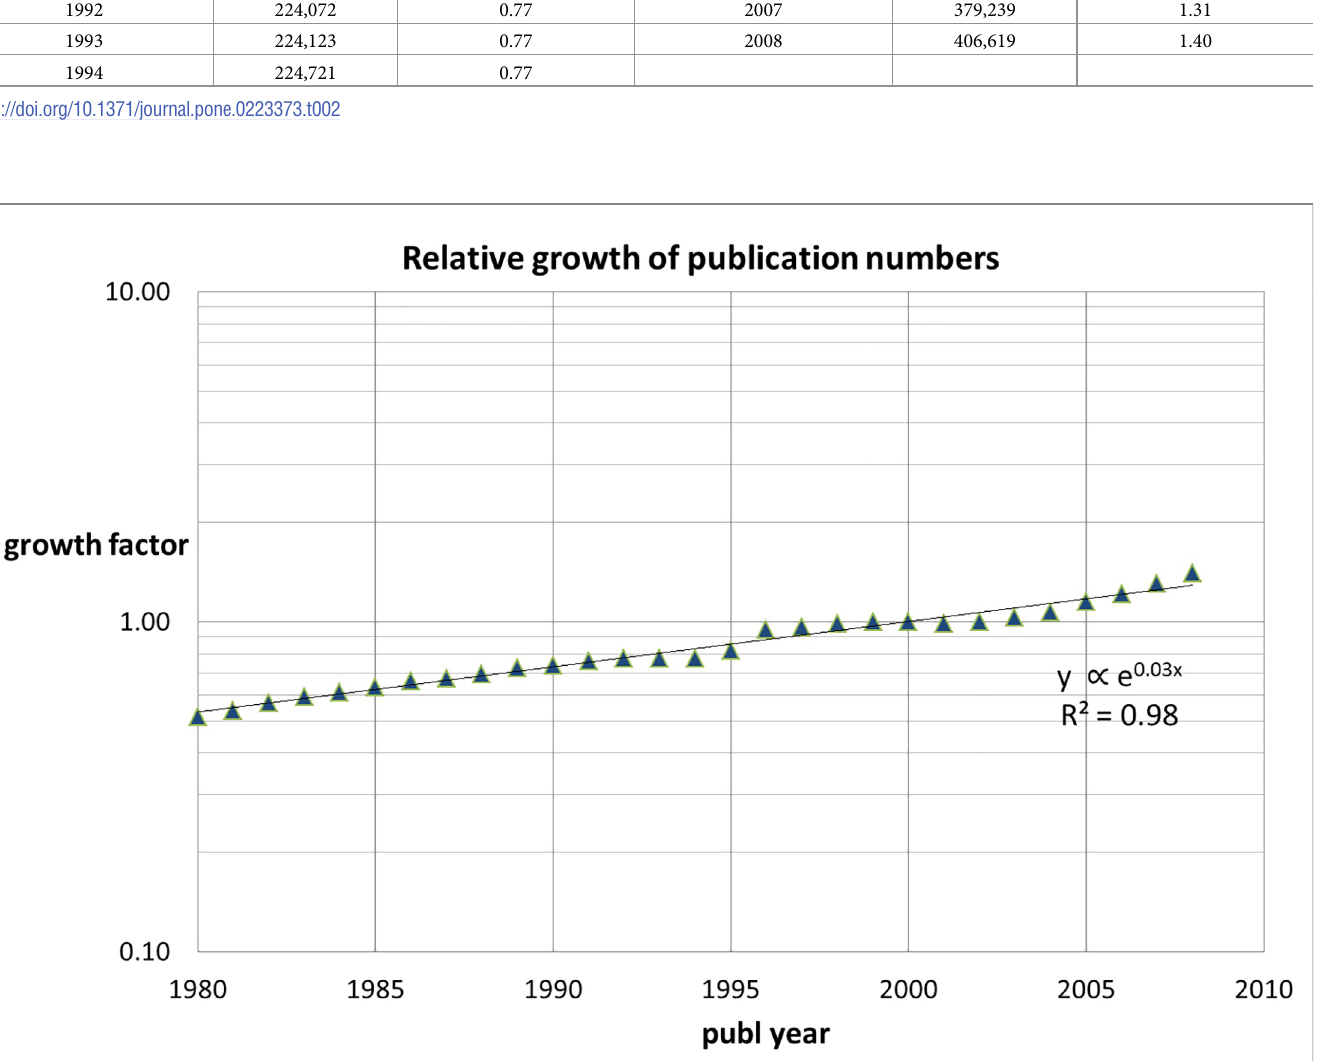
PLOS ONE | https://doi.org/10.1371/journal.pone.0223373 October 18,